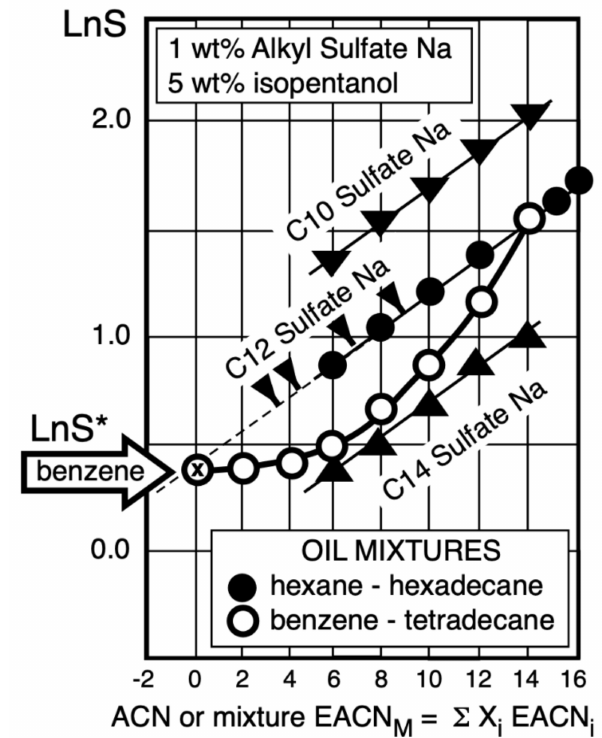
Figure 18. LnS vs ACN and oil mixtures. LnS* is experimentally determined with pure benzene and placed on the extrapolated LnS*-ACN dashed line for the C12 sulfate. Xs are the volume fractions in the oil